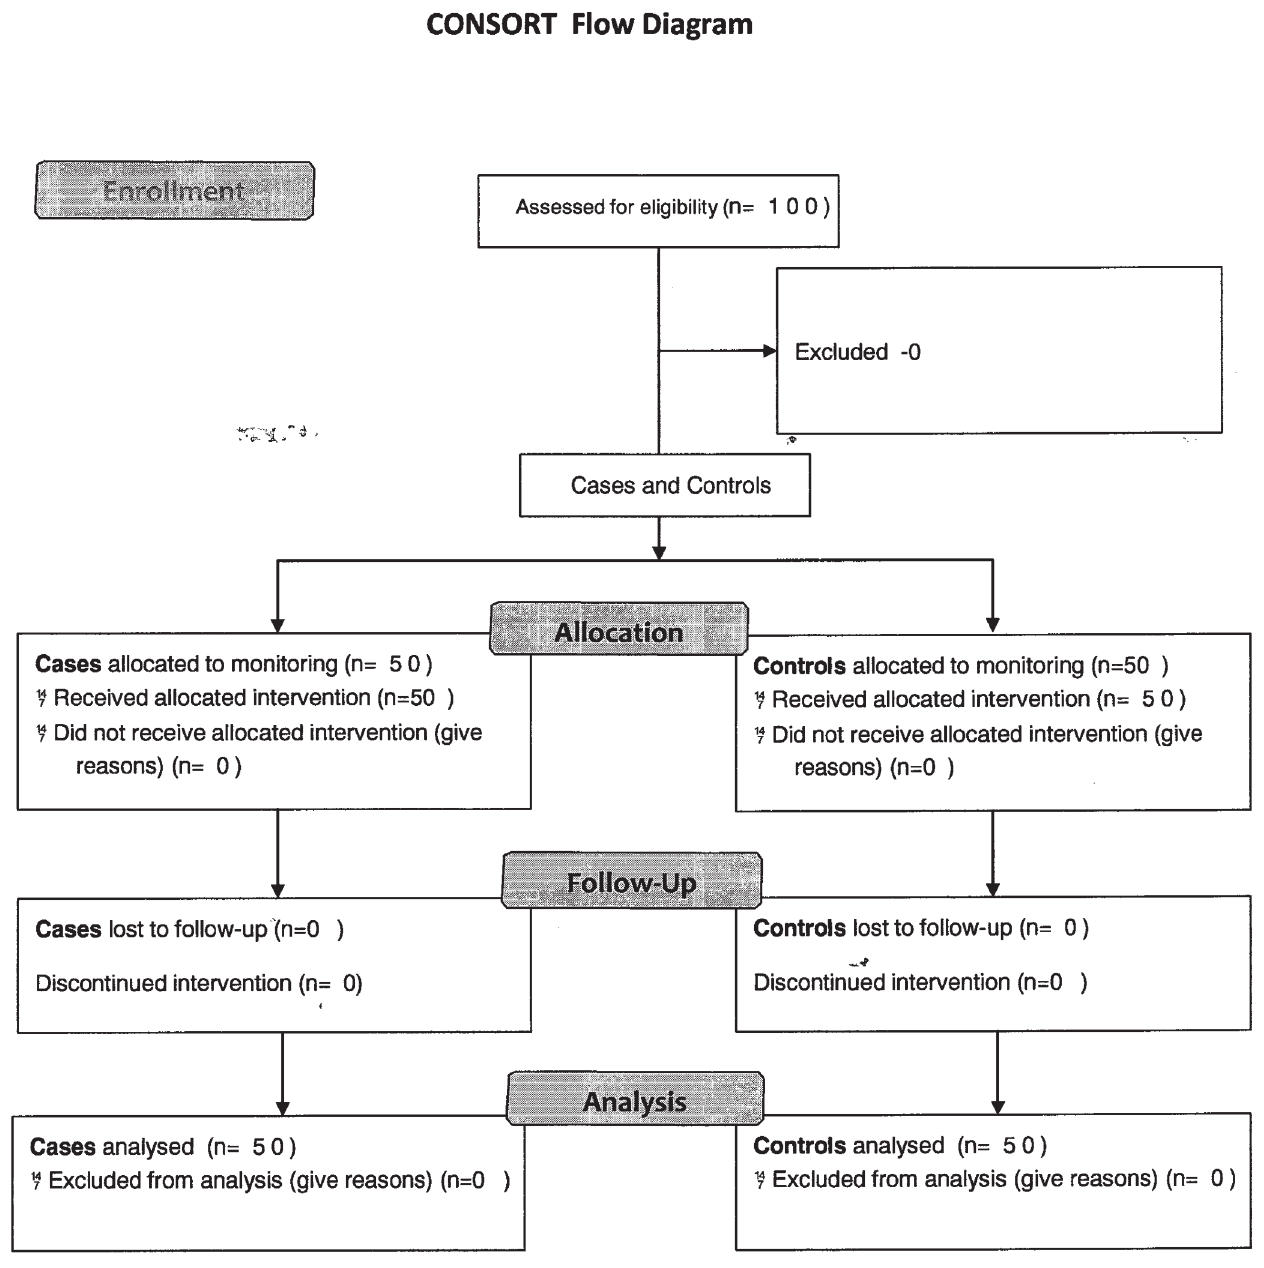
Fig 1. Consort Flow